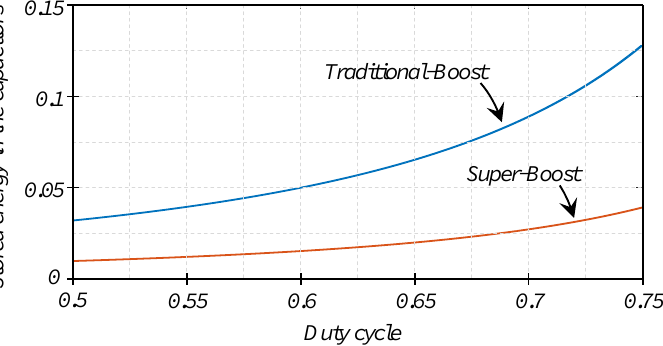
Figure 6. Comparison of stored energy in capacitors between the traditional boost and the super-boost converter for a case with the same output voltage ripple.